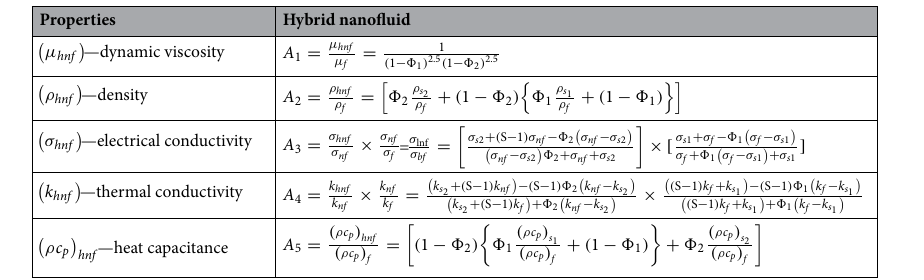
Table 1. Hybrid nanofluid thermo-physical features (Nazir et al. 50 and Khan et al. 51 ).